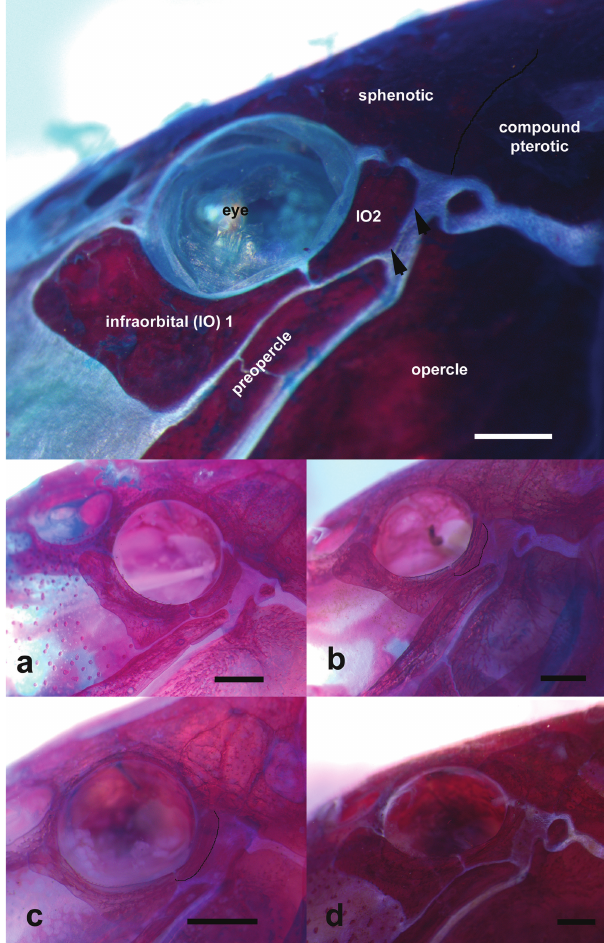
Fig. 4. Infraorbital series and adjacent cranial bones, lateral view, of: Scleromystax reisi , paratype, MNRJ 43857 (largest image, left side); a. S. salmacis , MCP 28729 (right side, flipped horizontally); b. S. macropterus , UFRJ 4442 (left side); c. S. prionotos , UFRJ 4428 (right side, flipped horizontally); d. S. barbatus , UFRJ 4440 (right side, flipped horizontally). Arrowheads showing ventral expansion of infraorbital 2. Solid lines detaching ventral margin of infraorbital 2 and bone sutures. Eye removed from specimens in a-d. Scale bar: 1.0 mm. Dorsal fin roughly ovoid; its origin just posterior to third dorsolateral body plate. Dorsal spinelet not embedded in adjacent dorsal spine. Ossified portion of dorsal spine shorter than first five-six branched rays; second branched ray longest. Distal tip of dorsal spine with short, segmented unossified portion. Anterior and posterior border of dorsal spine smooth. Dorsal-fin rays I,7(5), I,8*(54). Adipose fin roughly triangular; its origin separated from base of last dorsal-fin ray by 7(1), 8(19), 9*(23), or 10(11) dorsolateral body plates. Anal fin roughly triangular; its origin located just posterior to 13th ventrolateral body plate, at vertical through posterior margin of penultimate preadipose platelet. Anal-fin rays ii,4(1), ii,5(13), ii,5,i(3), or ii,6*(42). Pectoral fin roughly triangular; its origin located just posterior to gill opening. Ossified